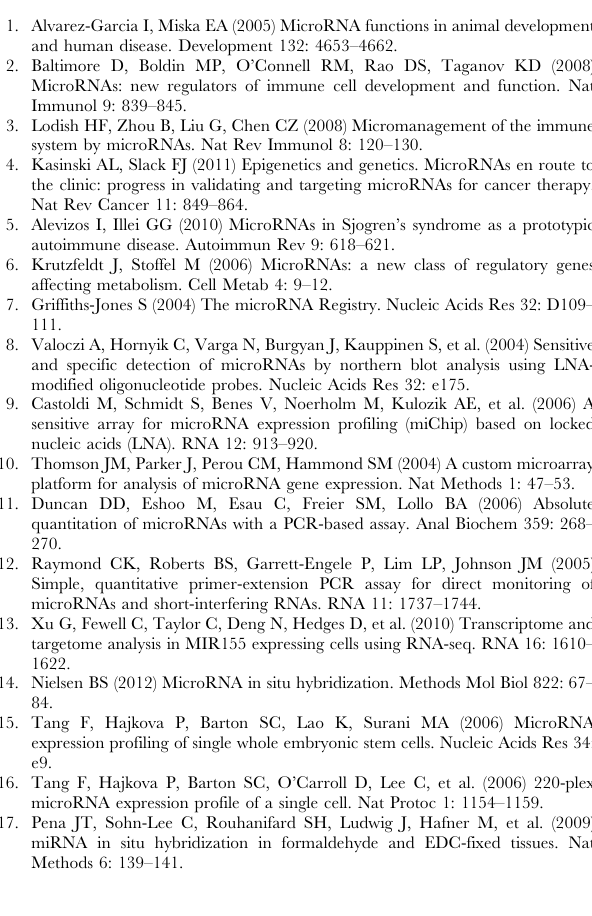
Figure S1 Details of the microfluidic platform. The